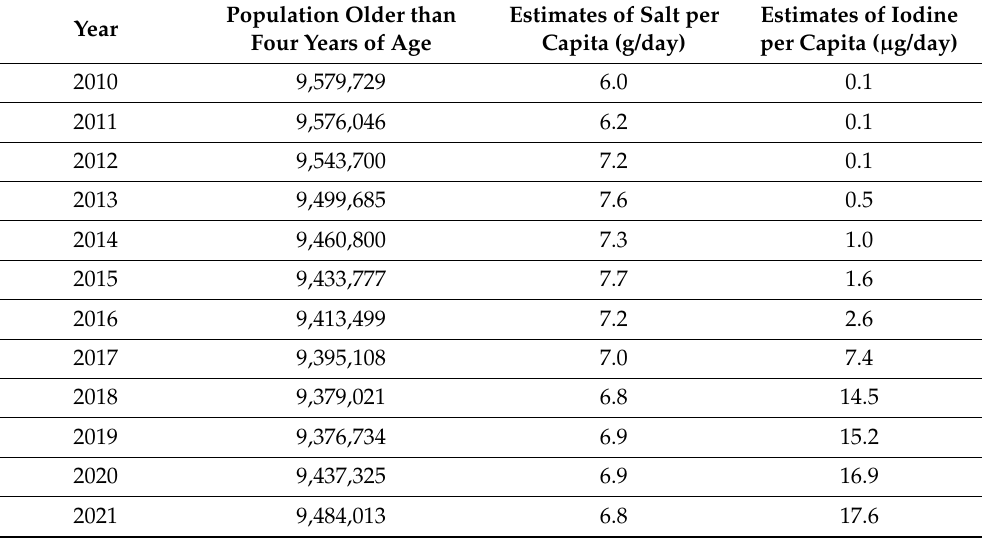
Table 3. Estimates of household availability of salt and iodine per capita, from 2010 to